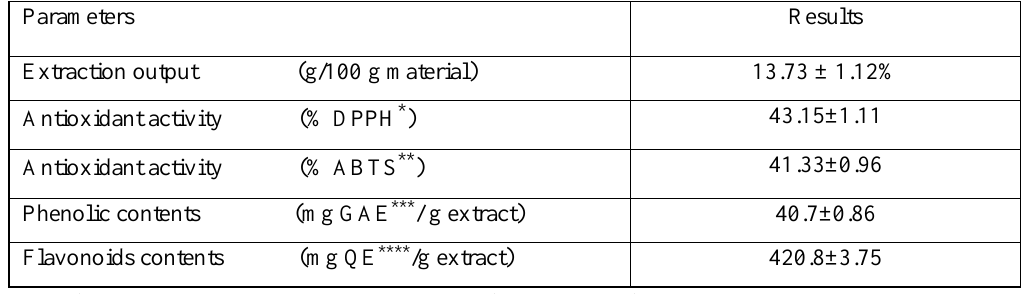
Table 2: Extracts output, antioxidant activities, total phenolic and flavonoid contents of ECV extract